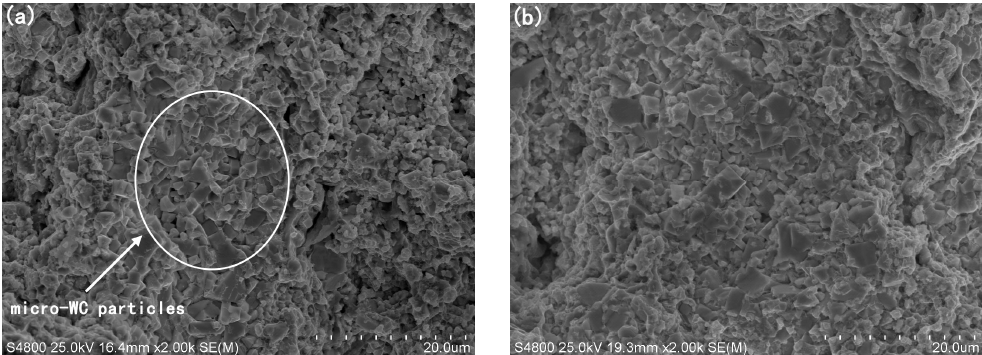
Figure 2. The fracture morphologies of samples: ( a ) S0; ( b ) S5.